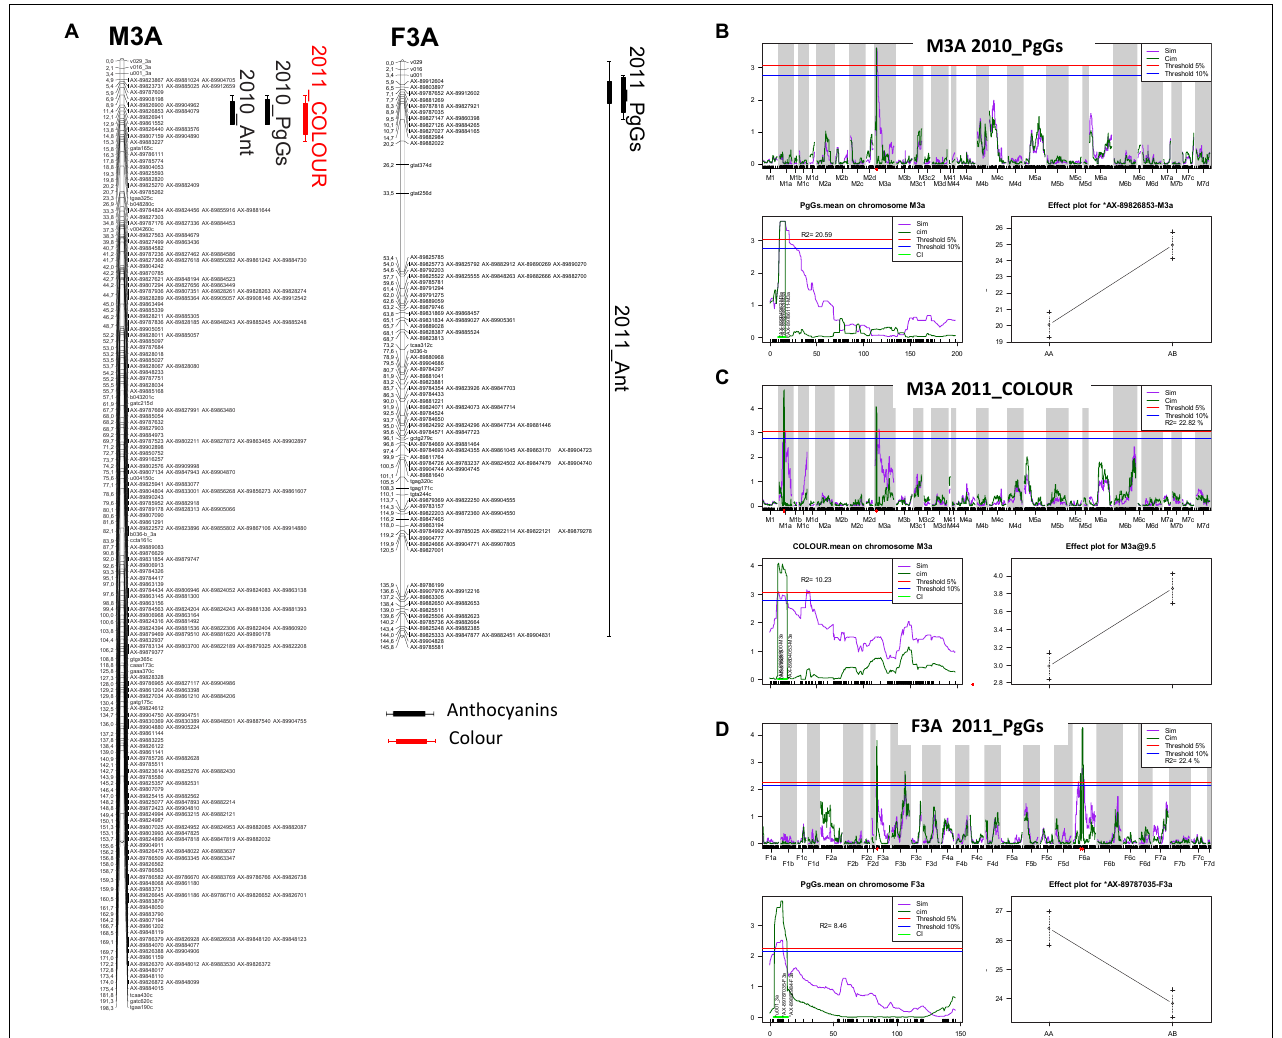
FIGURE 3 | Localisation of colour-related QTLs on the linkage groups M3A and F3A. (A) Mapchart of linkage group LG3A. Linkage groups are represented in MapChart 2.3 (Voorrips, 2002) with a space of 3 mm per cM. Each boxplot corresponds to a QTL identified with a threshold of 10%. Bayesian credible interval of QTL is indicated at 5%. Ant, total anthocyanins; PgGs, pelargonidin-3-glucoside; COLOUR, visual evaluation of fruit colour. Each QTL name is preceded by the year (2010_ or 2011_). mQTL scans and effect of markers linked to (B) 2010_PgGs and (C) 2011_COLOUR QTLs localised on linkage group M3A (male) and (D) 2011_PgGs QTL on linkage group F3A (female). For each of the three QTLs, genome scan (top), scan on specific linkage groups M3A or F3A (bottom left) and plot effect of the QTL marker (bottom right) are shown. For QTL genome scan and scan of specific linkage group, LOD values are shown on the y -axis and genetic positions in centiMorgans are on the x -axis. Simple and composite interval mapping analysis (SIM and CIM) are represented by the purple solid and the dark green solid lines, respectively. Threshold of QTL detection at 5% (red) and 10% (blue) for each trait is represented. In scan on specific linkage group, Bayesian credible interval of QTL is indicated at 5% in light green. For each QTL flanking markers, markers of QTL and variance ( R 2 ) are indicated. For each trait, effect of QTL is indicated at the marker corresponding to the maximal LOD value of